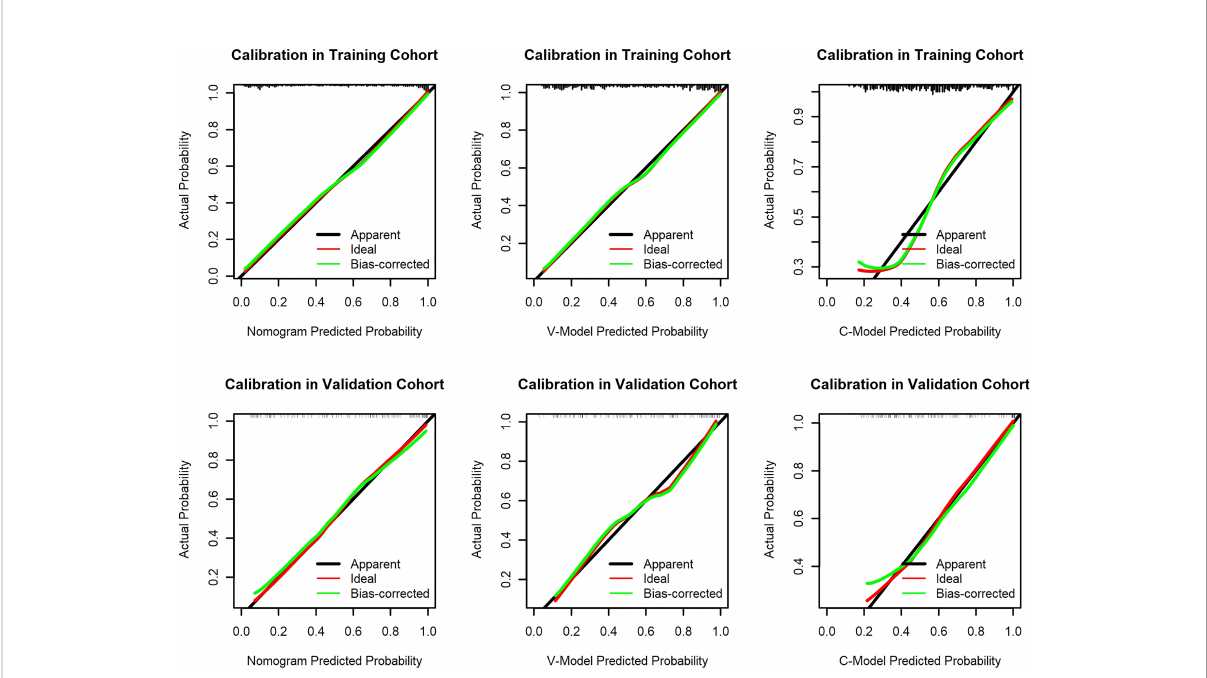
FIGURE 5 Calibration curves of the constructed models. The y-axis means the actual diagnosed diabetic retinopathy (DR). The x-axis meant the predicted risk of DR. The green lines represent the performance of the training cohort and validation cohort, which indicate a closer fi t to the red line. This represents a better prediction.